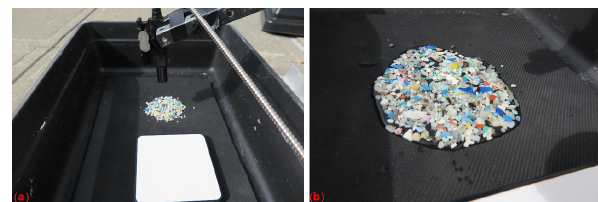
Figure 1. Experimental setup with the aggregated (a) dry and (b) wet marine-harvested microplastics. Black neoprene rubber was used as a background in a dark spray-painted container to mitigate background light during spectral reflectance